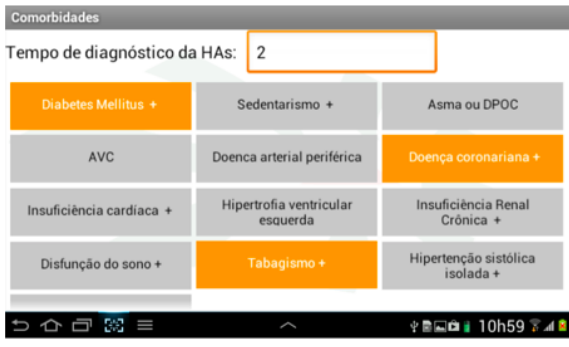
Figure 2. TeleHAS previous diseases and alerts menu.